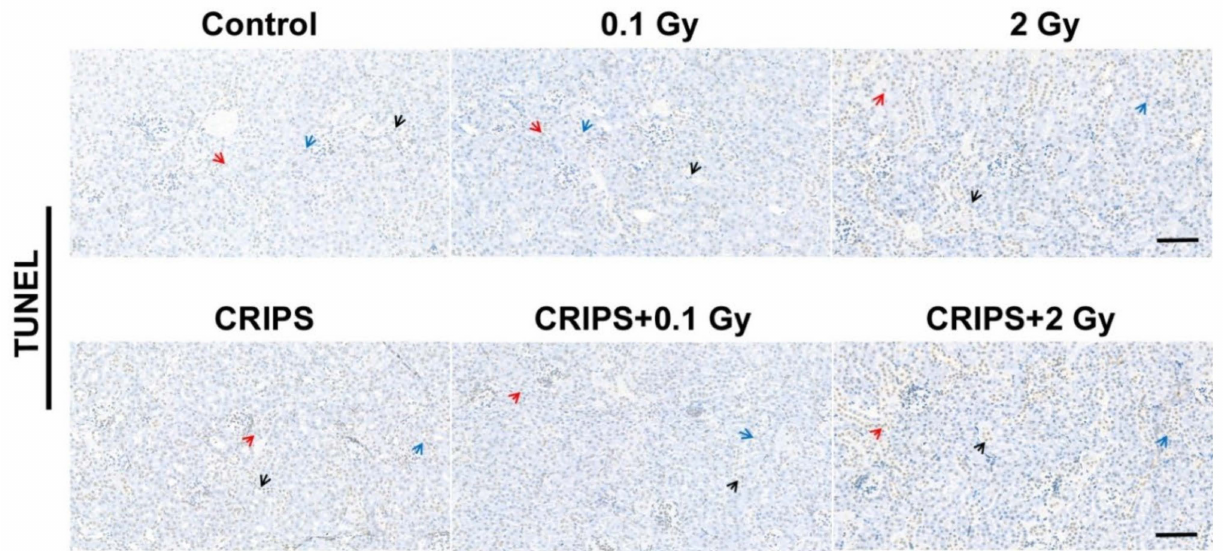
Figure 3. The apoptotic cells of renal sections detected by TUNEL assay in Trp53 +/ − mouse (magnifi- cation, 200 × ; scale bar = 100 µ M). Arrows indicate apoptotic cells (red arrow indicates renal tubular epithelial cells; black arrow indicates eosinophils; blue arrow indicates basophils). CRIPS, chronic restraint-induced stress.